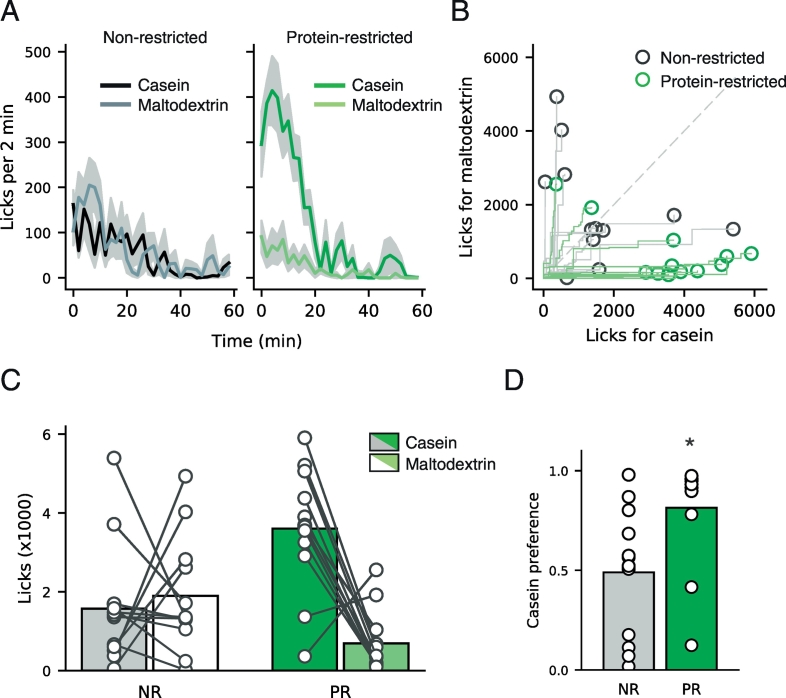
Protein-restricted rats show preference for protein over carbohydrate. After conditioning sessions rats were given access to both casein and maltodextrin solutions within the same session. (A) Time course of licking for casein and maltodextrin during the 1 h preference session. Similar rates of licking are seen for both casein (black line) and maltodextrin (grey line) in non-restricted rats whereas in protein-restricted rats elevated licking is observed to casein (dark green) vs. maltodextrin (light green). This licking predominantly occurs in the first twenty minutes of the session. Lines are mean and shaded area shows SEM. (B) Cumulative licks for casein vs. maltodextrin are shown for individual rats that were non-restricted (grey lines and black circles) or protein-restricted (green lines and circles). Consecutive licks are plotted with casein licks advancing along the x-axis and maltodextrin licks along the y-axis. Dashed grey line at unity represents absence of preference for either solution whereas markers to the right represent casein preference and markers to the left maltodextrin preference. The majority of protein-restricted rats lie to the right of this line indicating protein preference whereas non-restricted rats are evenly distributed. (C) Licks of casein vs. maltodextrin during preference session. Conventions are identical to Fig. 2. (D) Casein preference calculated as casein licks divided by total licks. Protein-restricted rats (green bar) show an increased preference for casein, relative to non-restricted rats (grey bar). Bars are mean and circles are data from individual rats. *p < 0.05 vs. non-restricted rats. [figure = 1.5 columns]. (For interpretation of the references to colour in this figure legend, the reader is referred to the web version of this article.)